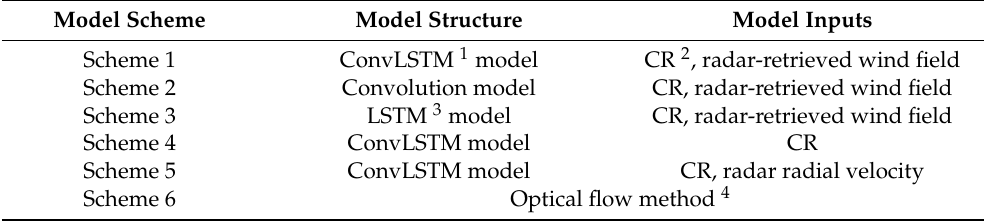
Table 1. The model scheme settings.